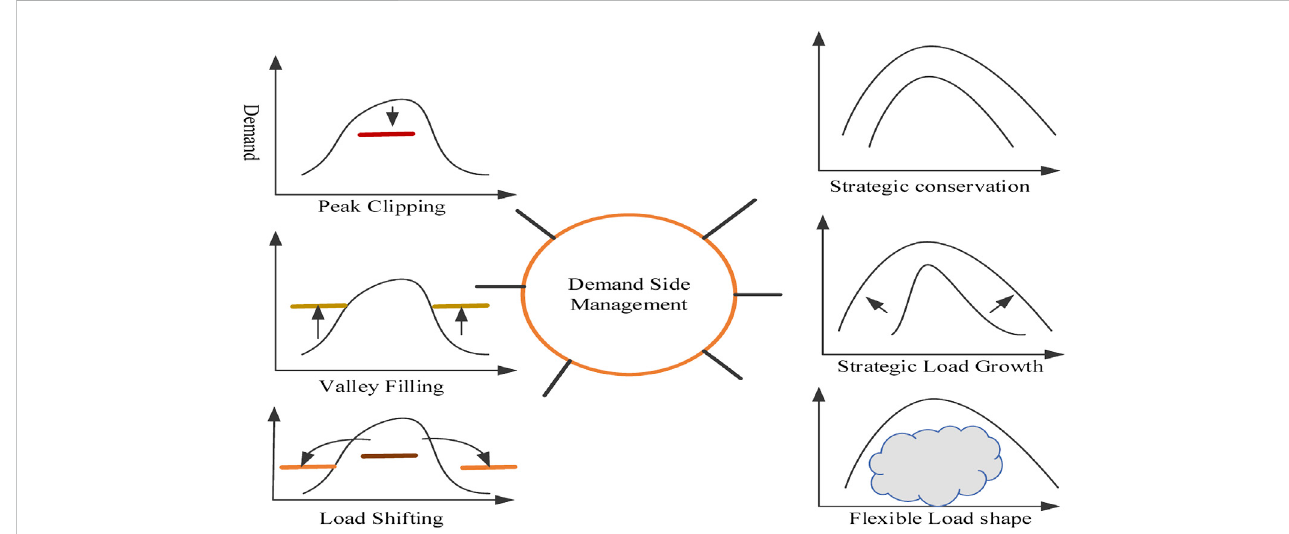
FIGURE 3 DSM techniques.